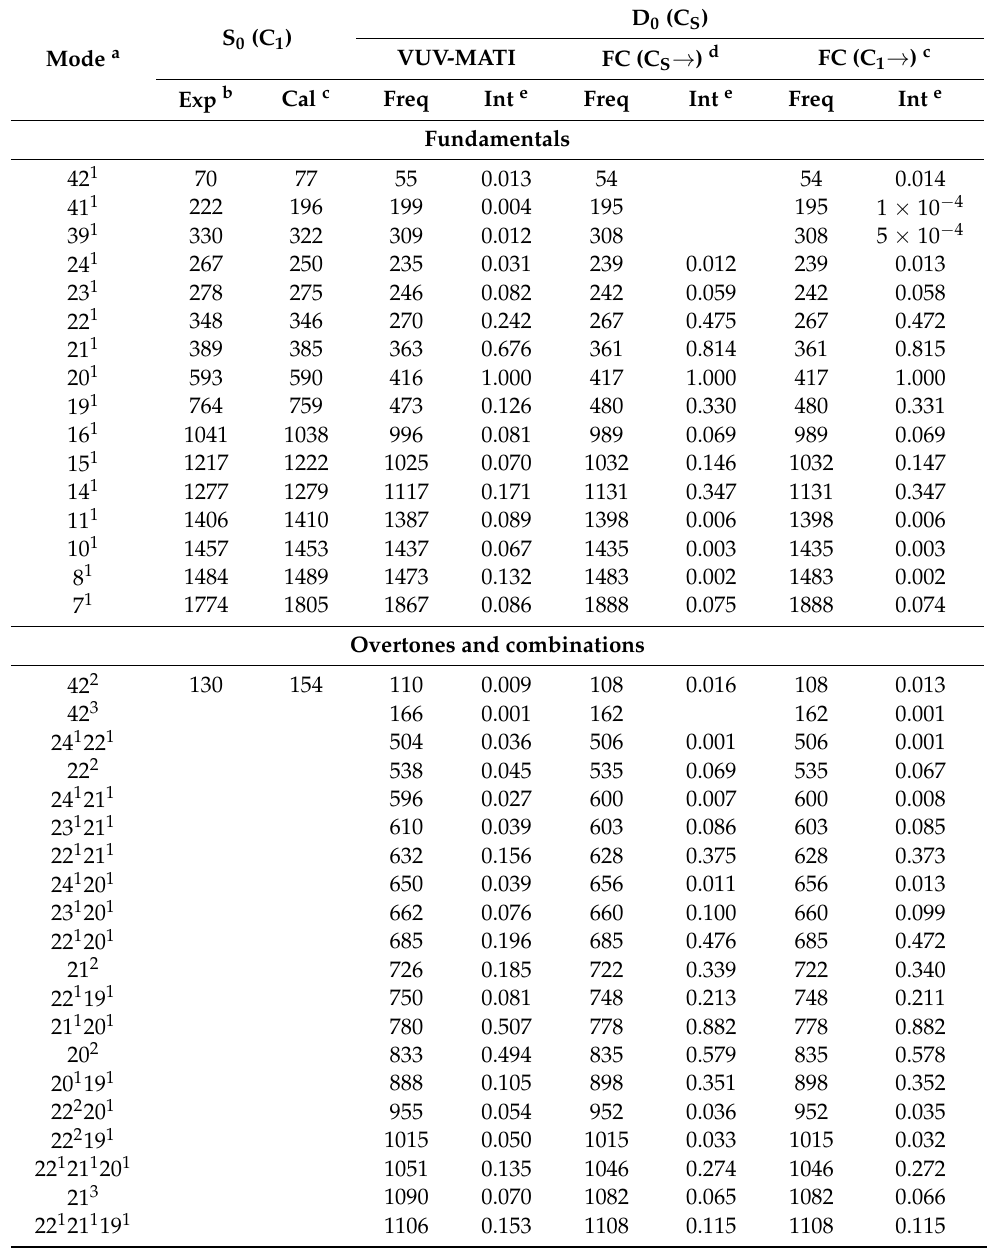
Table 1. Experiment and calculated vibrational frequencies (cm − 1 ) of pivaldehyde in S 0 and D 0